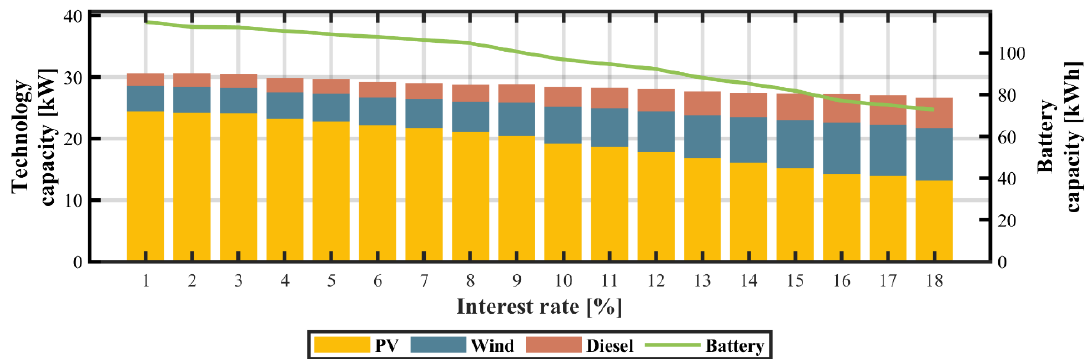
Figure 21. Simulation results of interest rate variation. Impact on the capacity of DG technologies.